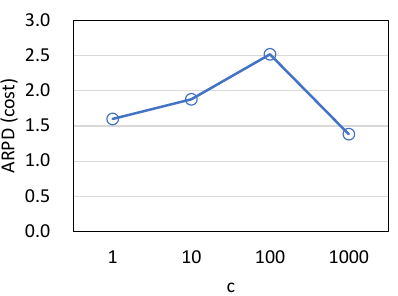
Figure 18. ARPD corresponding to Figure